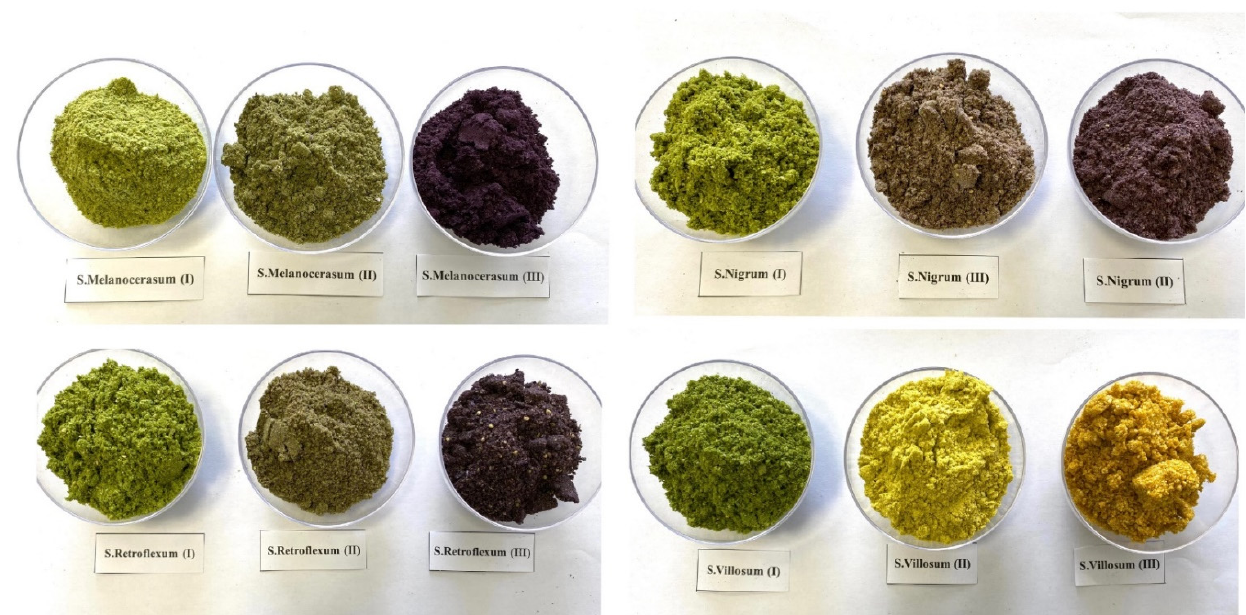
Figure 5. Fruit ripening stages of Solanum spp. represented by milled fruit samples. (photos by J. Staveckien ė ).